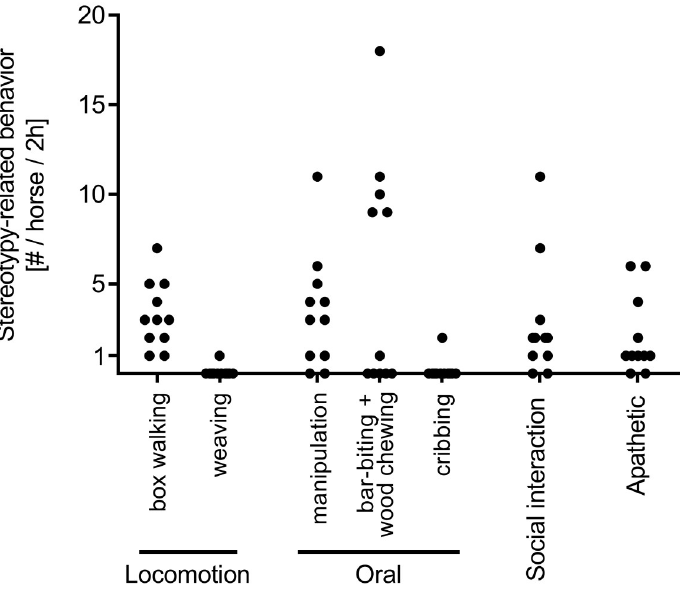
Fig 6. Horses show stereotypy-related behavior one week after relocation to single housing. Number of stereotypy- related behavior or its pre-stages per individual horse and category are depicted by black circles.